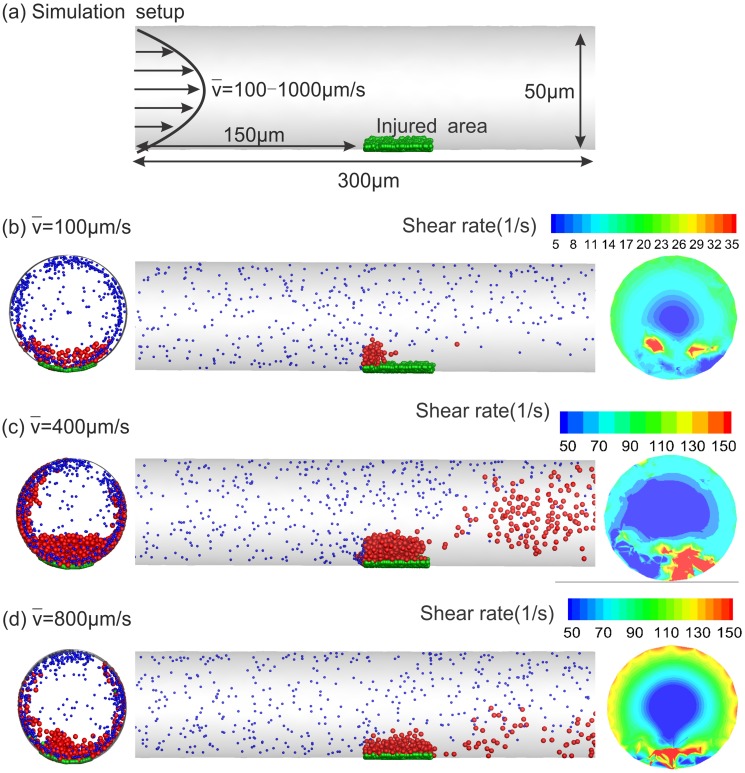
Snapshots of low-shear blood clotting in a 50μm circular tube.(a) schematic of the simulation setup; (b), (c) and (d) velocity at the inlet is parabolic with the mean velocity equal to 100, 400, 800 μm/s, respectively. Green particles represent the seeded platelets at the site of injury, whereas blue and red particles are passive and activated platelets, respectively. Blue particles are plotted smaller for clarity. Activated particles can form thrombus and adhere to the injured wall. The circular plots on the left column present the side views of each tube showing the clot that is formed by activated platelets, whereas the circular plots on the right column are cross-sections taken at the center of clots showing the contours of λ2 on those planes.